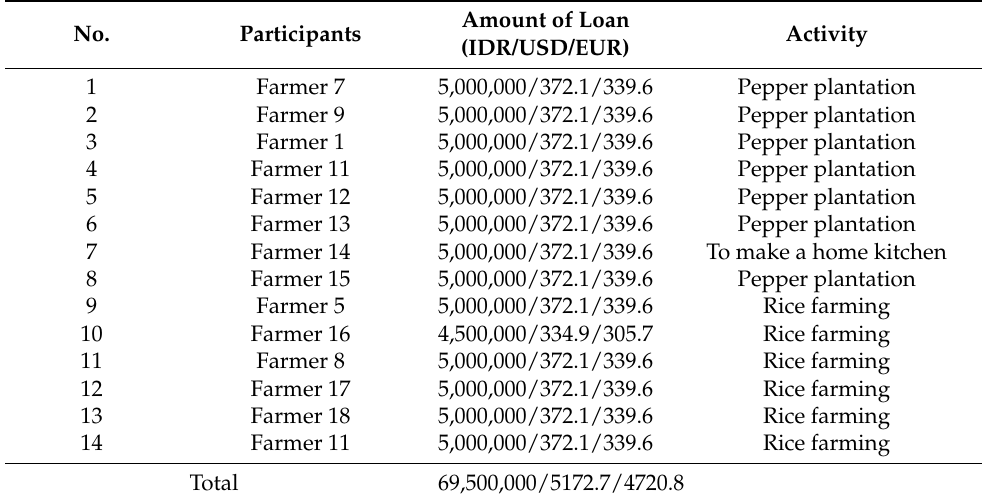
Table 6. Loan distribution among the Sumber Rejeki group 2016–2017 (2016 rates USD 1 = IDR 13,436 and EUR 1 = IDR 14,722).